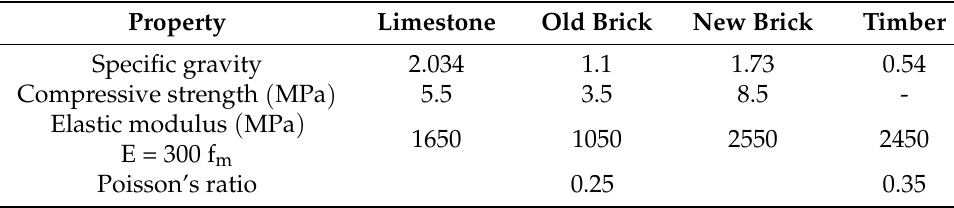
Table 1. Material properties selected for the numerical